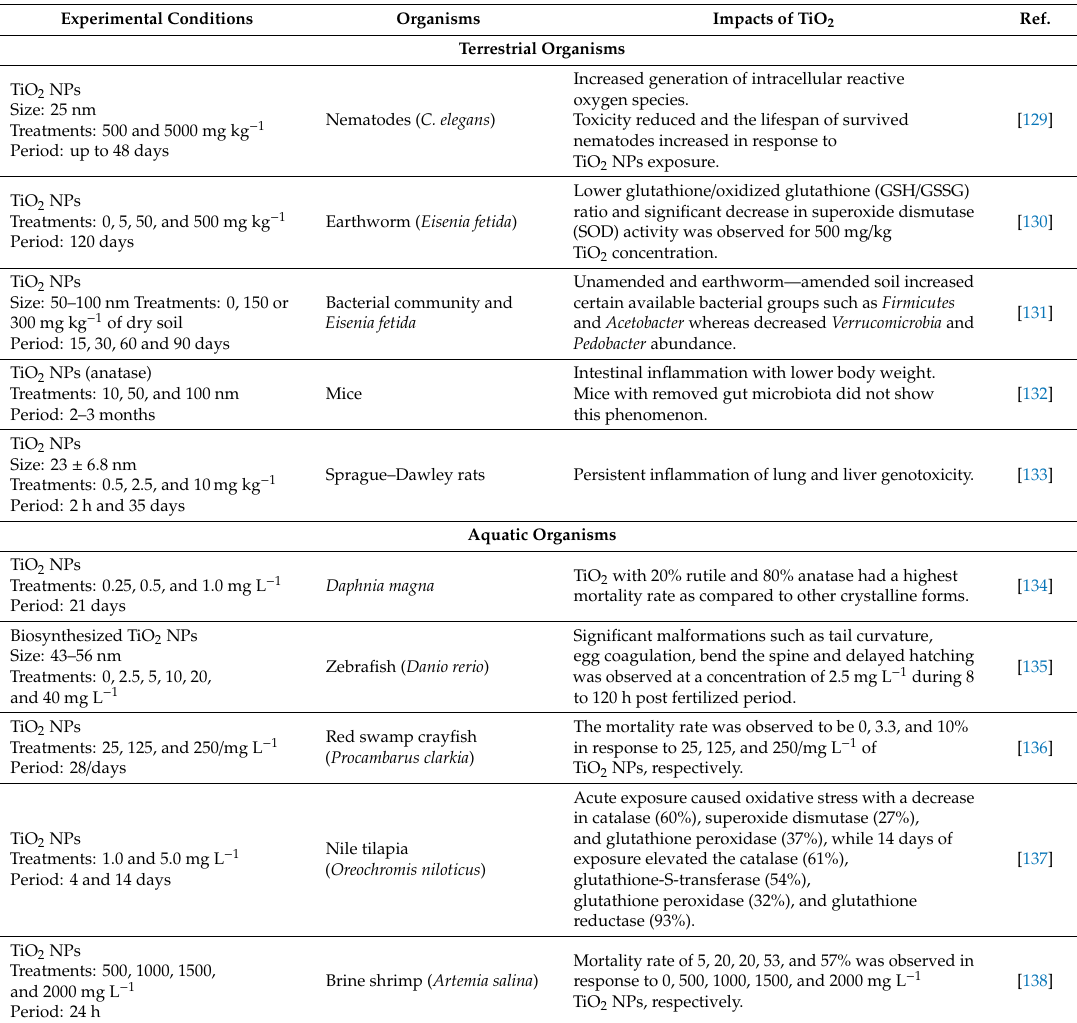
Table 5. TiO 2 NPs e ff ects terrestrial and aquatic